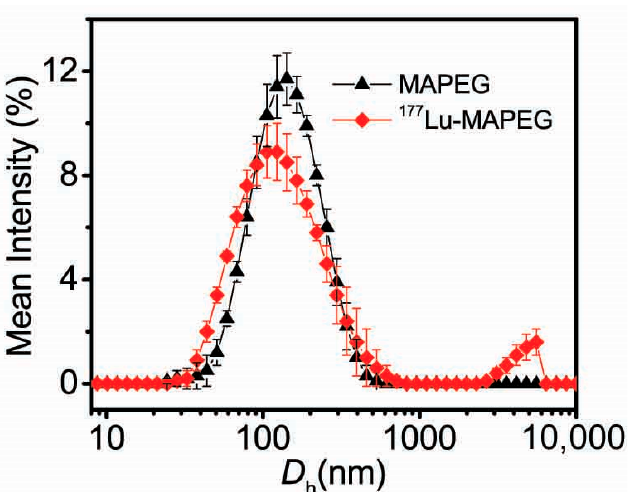
Figure 5. Representative radio-TLC chromatograph of [ 177 Lu]Lu-MA or [ 177 Lu]Lu-MAPEG after 30 min of incubation at 75 °C.